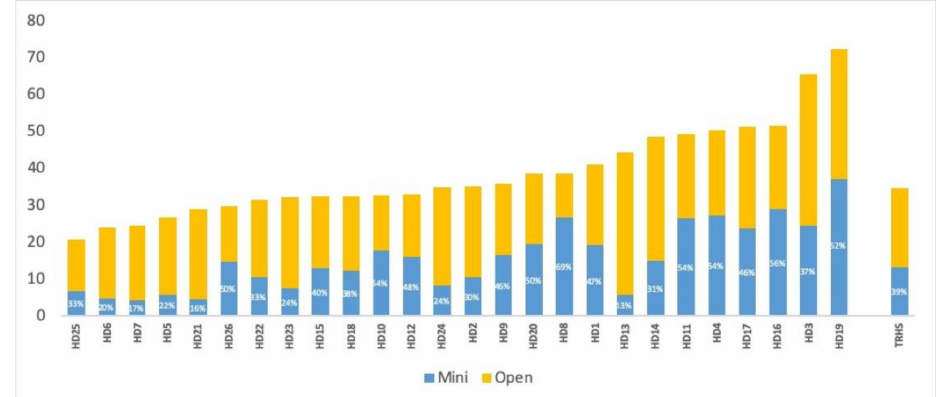
Figure 2. Treatment rates for 100,000 inhabitants (std)—2018, Tuscany.